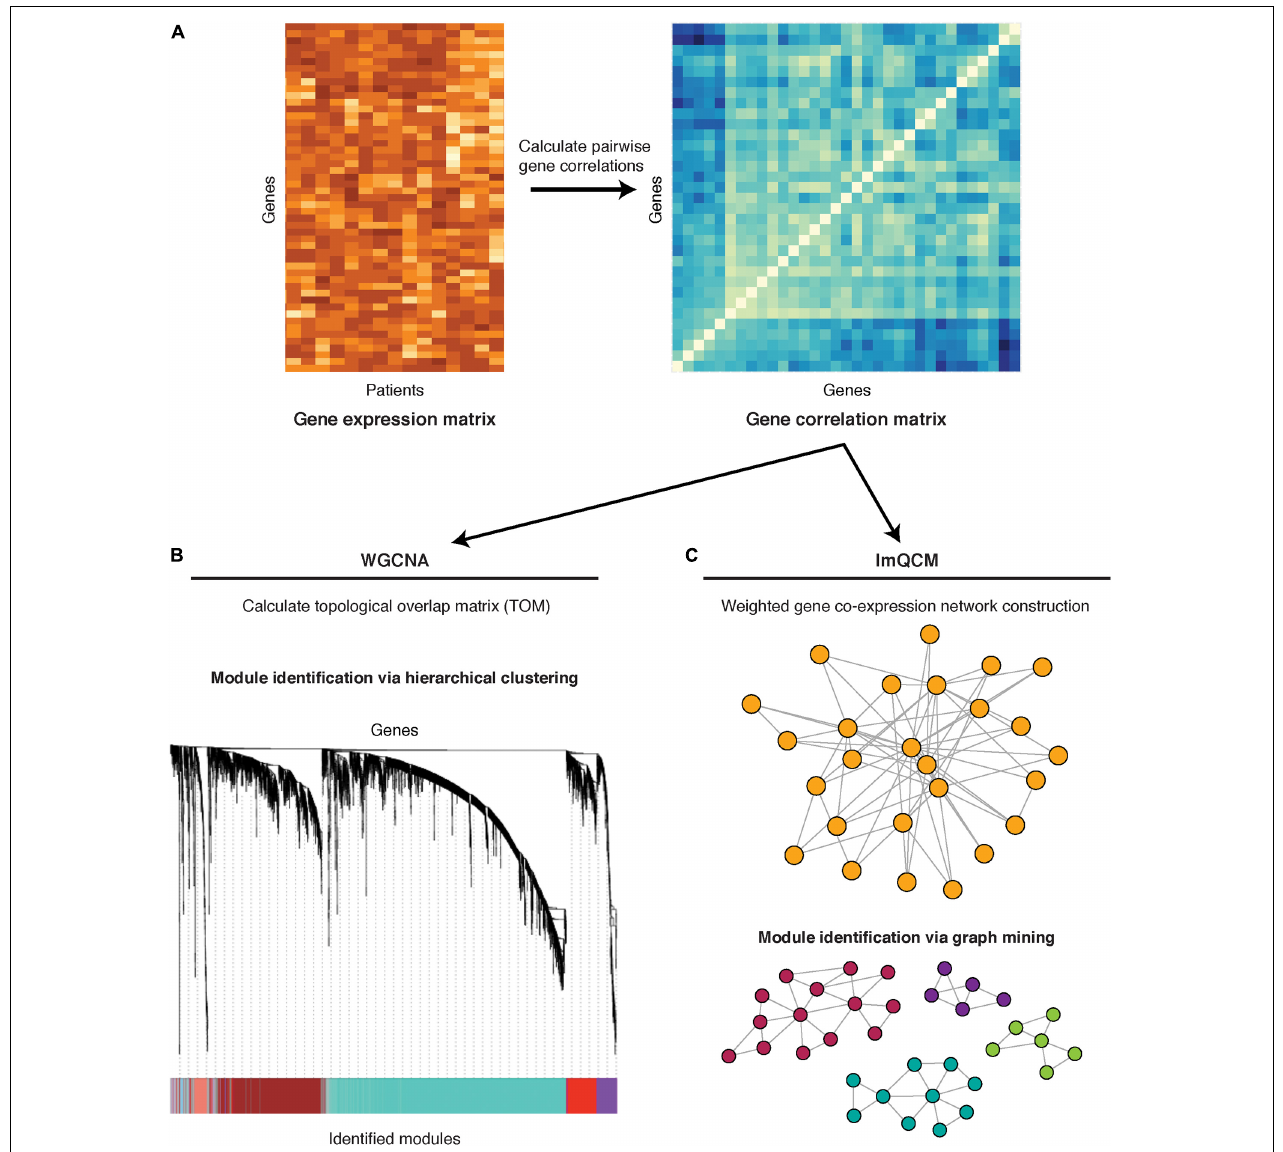
FIGURE 2 | Co-expression network methods: WGNCA and lmQCM. (A) Pairwise gene correlations are calculated from gene expression (microarray or RNA-seq) data. (B) The co-expression matrix is transformed into a topological overlap matrix and subjected to hierarchical clustering for module identification. A cluster dendrogram is shown, with different gene modules identified by the color bar on the bottom. (C) The co-expression matrix is used to construct a network, with genes as nodes and the correlation co-efficient between any two genes as the edge weight. Module identification is achieved through a greedy search for highly correlated